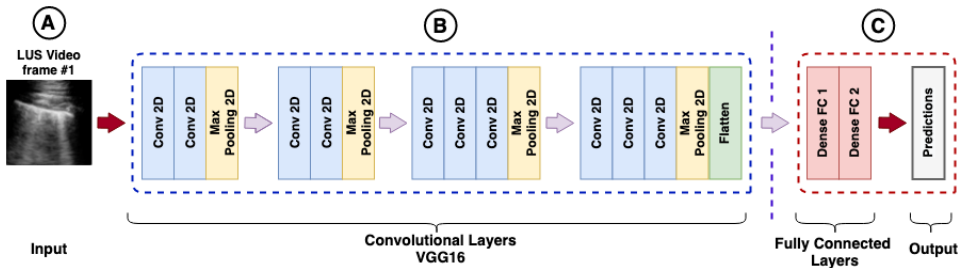
Figure 2. Example of feature extraction using a VGG16: ( A ) represents the input layer of VGG16 ( 224 × 244 × 3 ) . ( B ) represents the convolutional base, with convolutional layers, pooling, and flatten operations (convolutional layer output). ( C ) represents the fully connected layers, followed by the prediction layer (output layer). The layers represented in ( C ) need to be removed for the convolutional neural network (CNN) to work as a feature